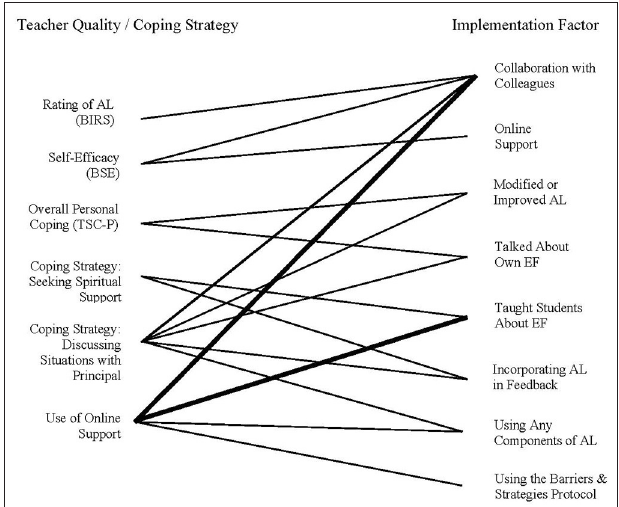
FIGURE 2 | Teacher qualities and coping strategies correlated with implementation factors. Solid lines represent positive correlations between r(81) = 0.22 and 0.36, p < 0.05. Heavier lines represent positive correlations between r(81) = 0.45 and 0.52, p < 0.05. BIRS is the Behavioral Intervention Rating Scale (Elliott and Von Brock Treuting, 1991). The BSE is Bandura Self-Efficacy Survey (1989). TSC-P is the Teacher Stress and Coping Scale ( Forlin, 2001), measures of personal